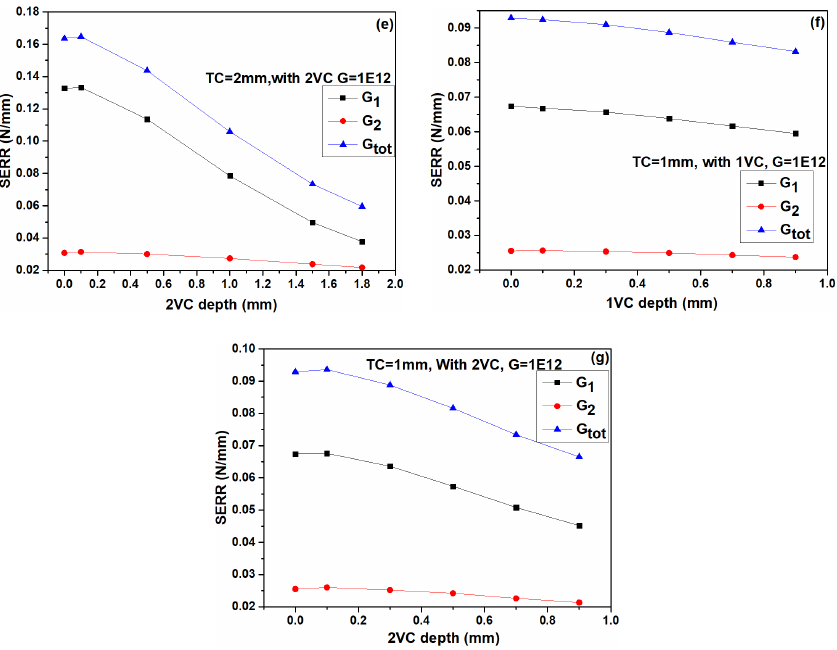
Figure 11. SERR 11 , SERR 12 , and SERR total at crack tip affected by, thickness of TC ( a ) and depth of vertical pores at different thicknesses of TC ( b – g ).